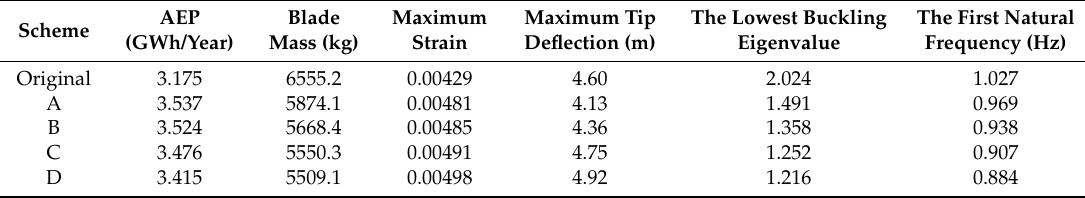
Table 6. Comparison of the annual energy production (AEP), blade mass and structural performance.